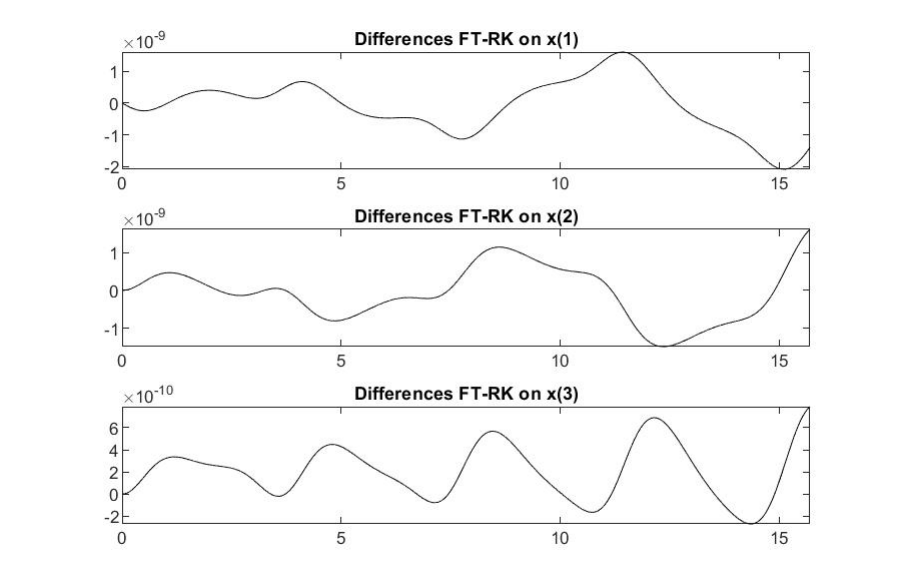
Figure 2. Problem No1: Differences FT ( t ) − RK ( t ) between the FT solution and the RK solution for the three components x j ( t ) , j = 1,2,3. The two solutions coincide up to precision 10 − 9